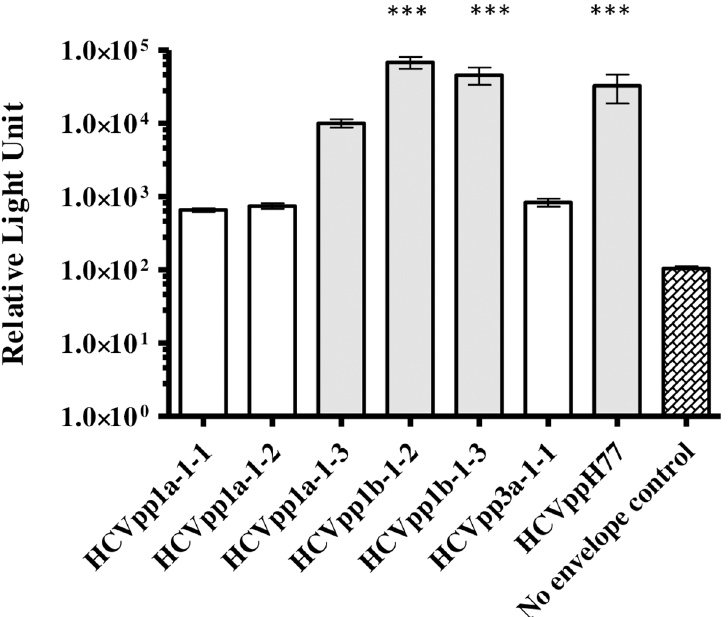
Fig 1. Varying degree of infectivity of E1E2 glycoproteins derived from AAV HCVpp. HCVpp generated from E1E2 associatedwith AAV showedvaryingdegreeof infectivity. HCVpp generatedfrom phCMV- Δ C/E1/ E2 H77 were used as reference HCVpp. No envelope control reproducibly gave RLU values less than 100, therefore a cut-off of 1000 RLU was used to determine the infectivity of a clone ( *** p < 0.0001, one way ANOVA, Dunnett’s posthoc test) The X axis depicts infectiousHCVpp clones (shadedboxes, n = 3/6) in this study. Y axis denotesinfectivity in relative light units (RLU). GT: